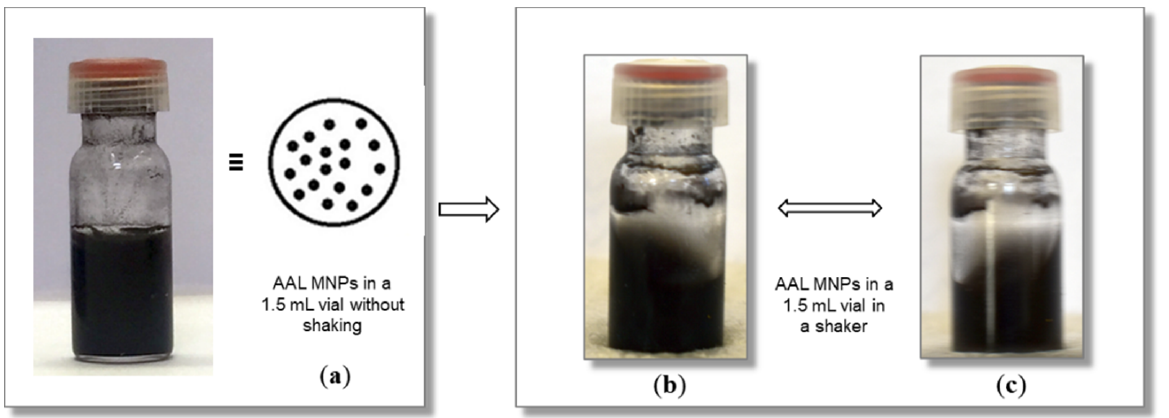
Figure 1. The aspartate ammonia-lyase biocatalyst immobilized on magnetic nanoparticles (AAL-MNPs) ( a ) as a suspension in a non-agitated vial and ( b , c ) in a reaction performed in a shake vial (SH). Pictures ( b , c ) show two opposite-position states of the reaction vial in a real orbital shaker (note the significant portion of AAL-MNPs stuck on the wall).